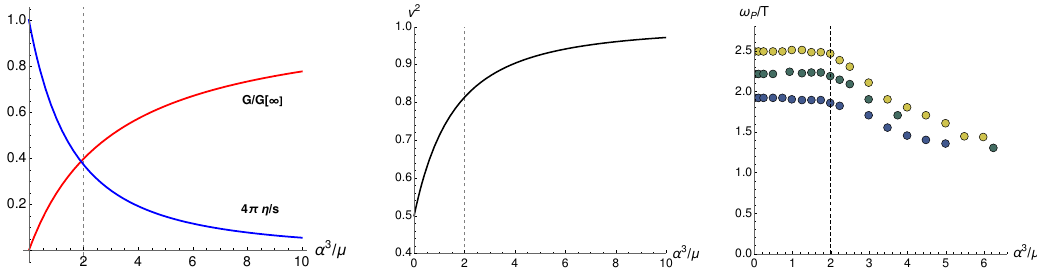
Figure 14 . Transition point in various observables. The values appear to be very correlated to each other and independent of (cid:21)